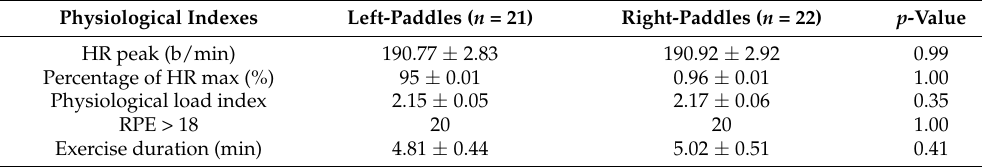
Table 2. 1000 m dragon boat ergometer exercise performance and exercise performance ( x ± s, n = 43). Physiological Indexes Left-Paddles ( n =